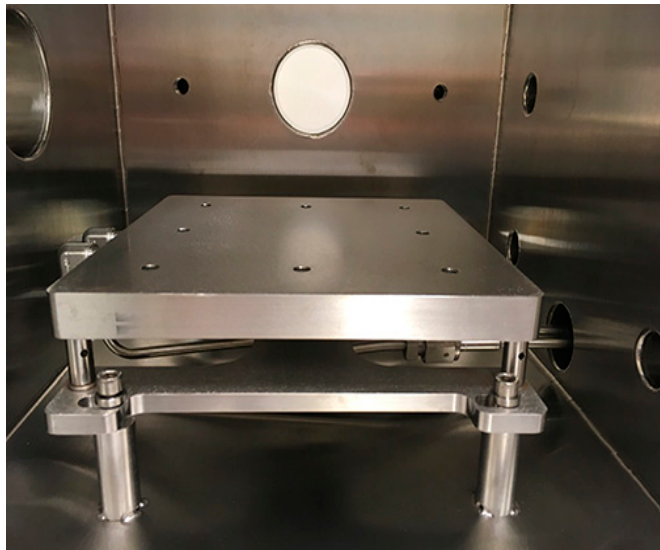
Figure 3. Detailed view of the cooling plate setup, which allows for the flow of liquid nitrogen.